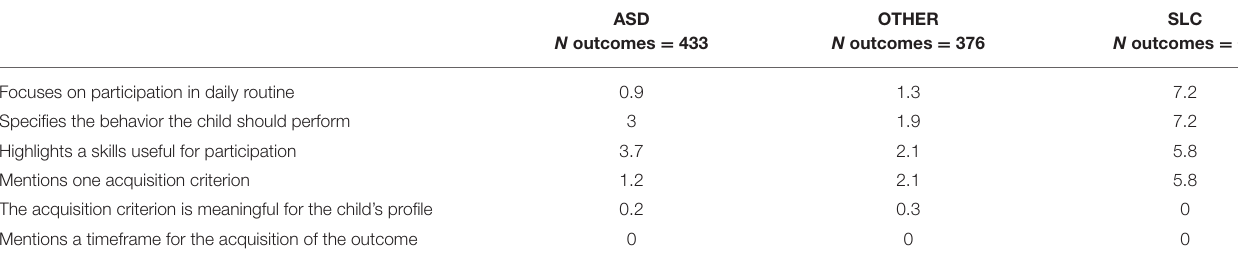
TABLE 5 | Percentage of high quality outcome ratings per type of need across GFS II